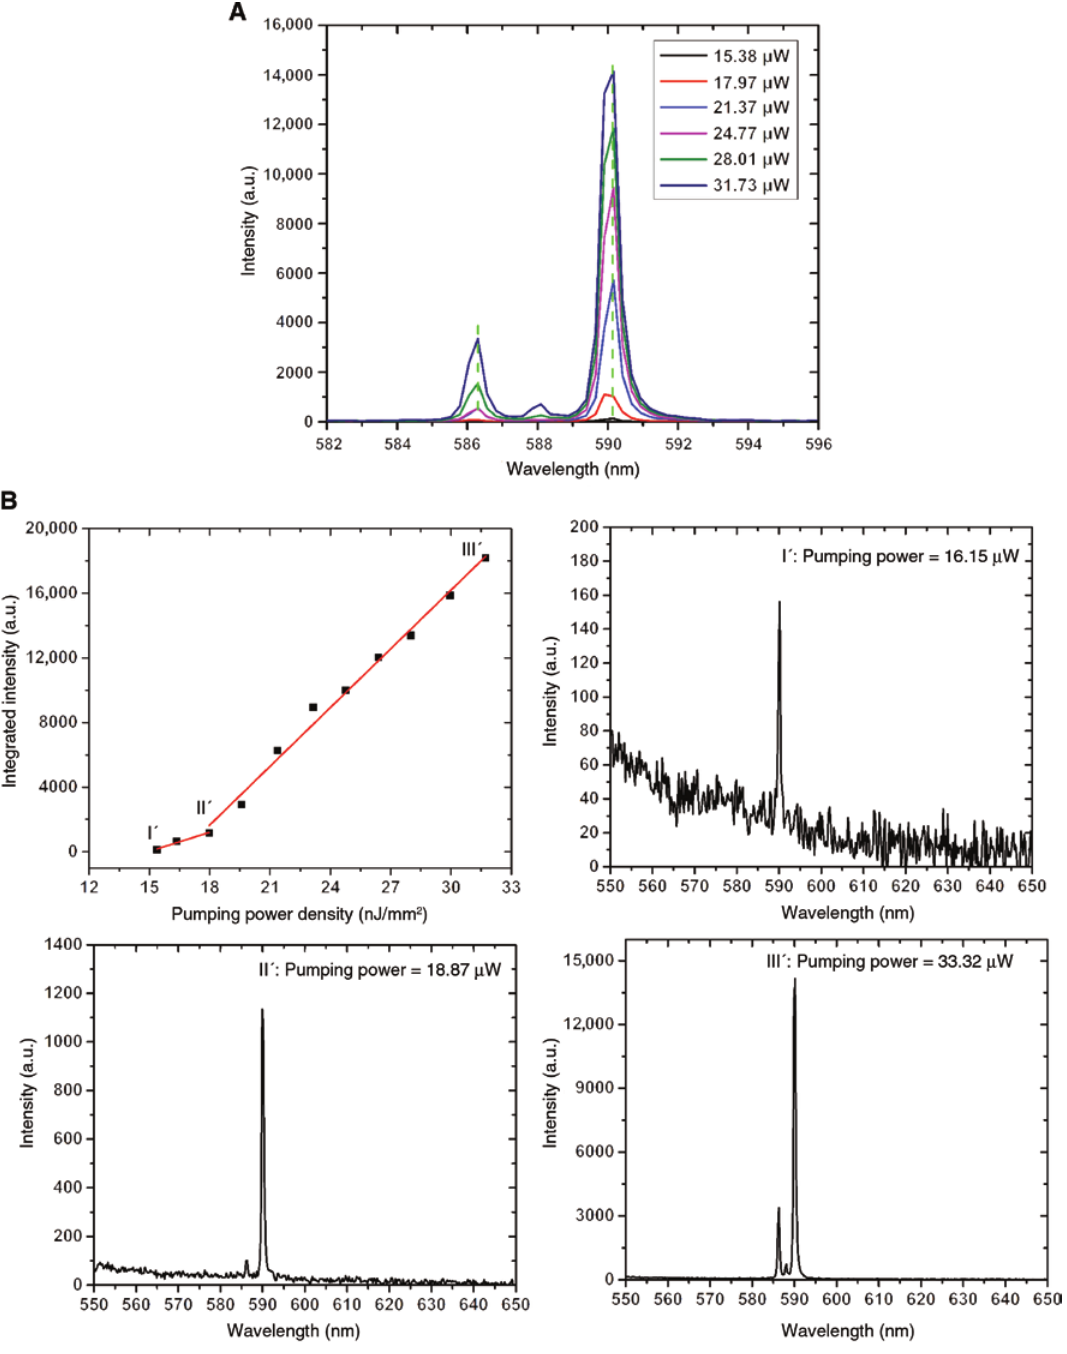
Figure 6: Slope efficiency curve of the laser and typical emission spectra under various pumping powers when 1 mmol/l RHB solution is used. (A) Typical laser emission spectra recorded under different pumping powers when the RHB concentration is 1 mmol/l. (B) Relationship between the integrated laser emission intensity and pumping power, and spectra recorded under various pumping